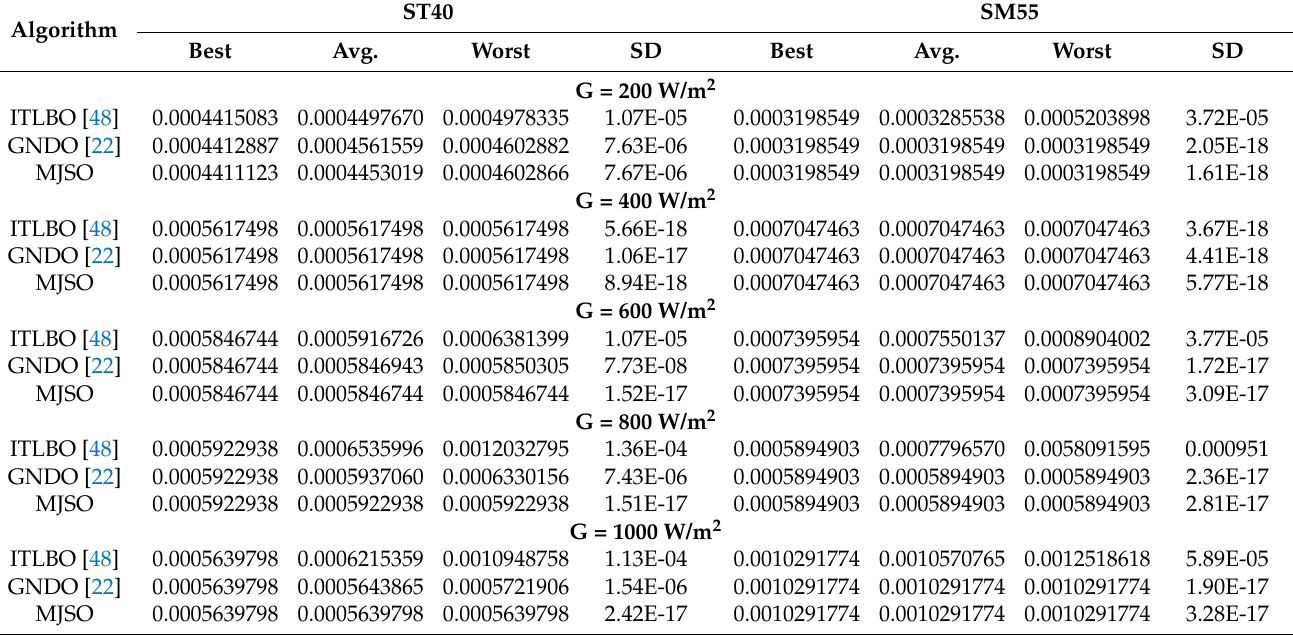
Table 17. Comparison at T = 25 ◦ C and at various